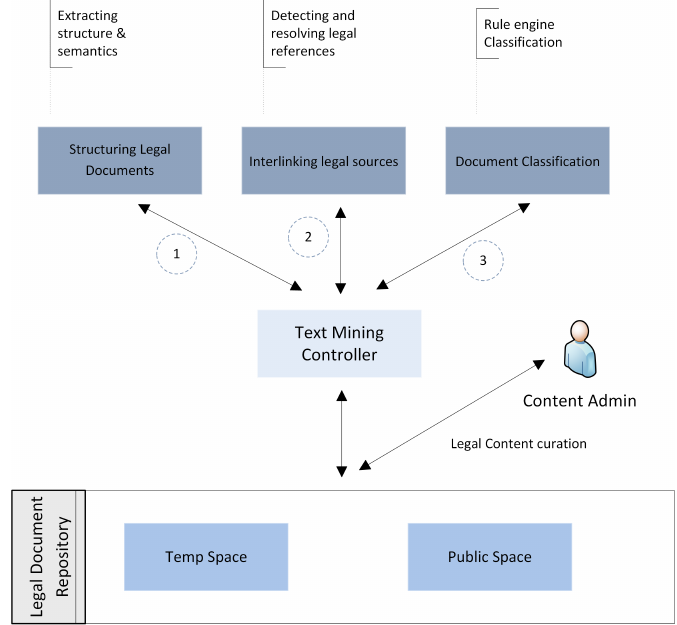
Figure 7. Text Mining Process. Unstructured documents are firstly transformed to a suitable for modelling legal sources format, capturing the legal semantics. Afterwards legal citations are discovered and resolved and finally documents are assigned to one or more classes or